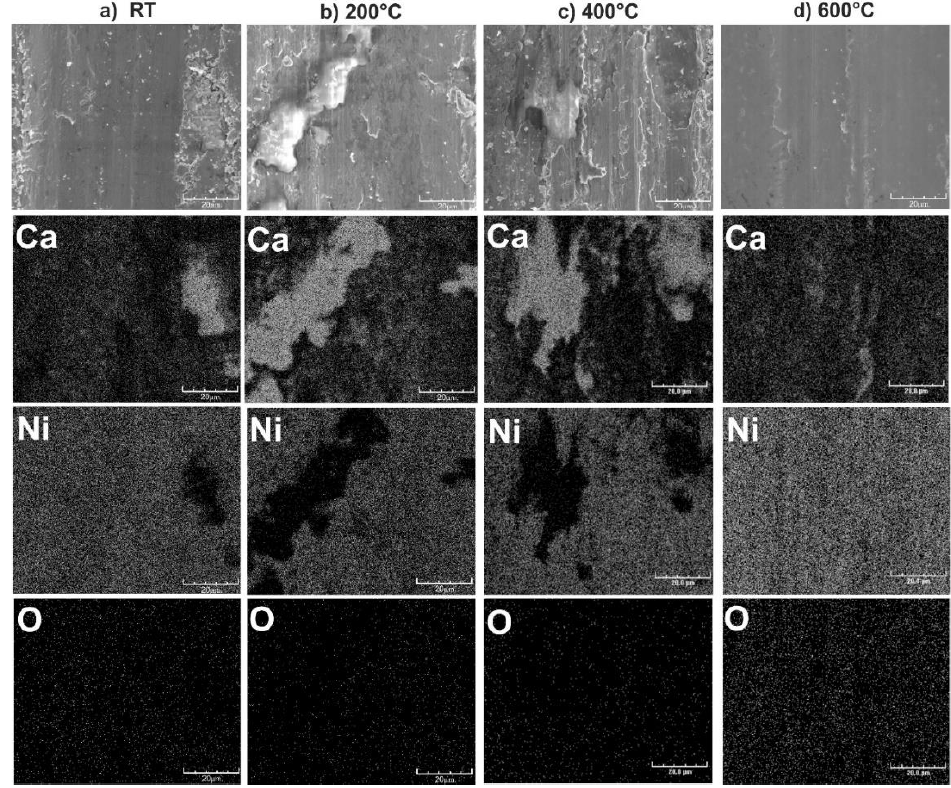
Figure 5. The EDS analysis of the surface of the samples after wear tests of Ni-10% CaF 2 self-lubricating composites at different temperatures.